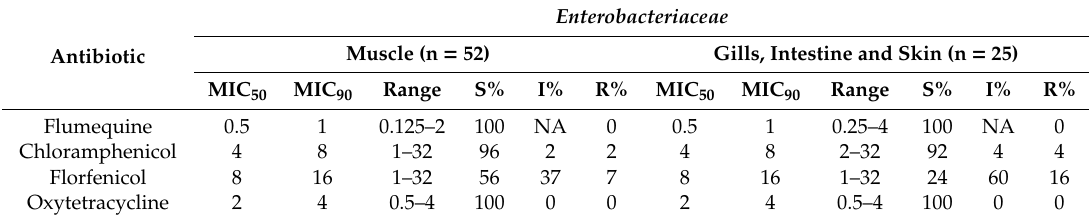
Table 7. MIC 50 and MIC 90 for Enterobacteriaceae strains ( n =